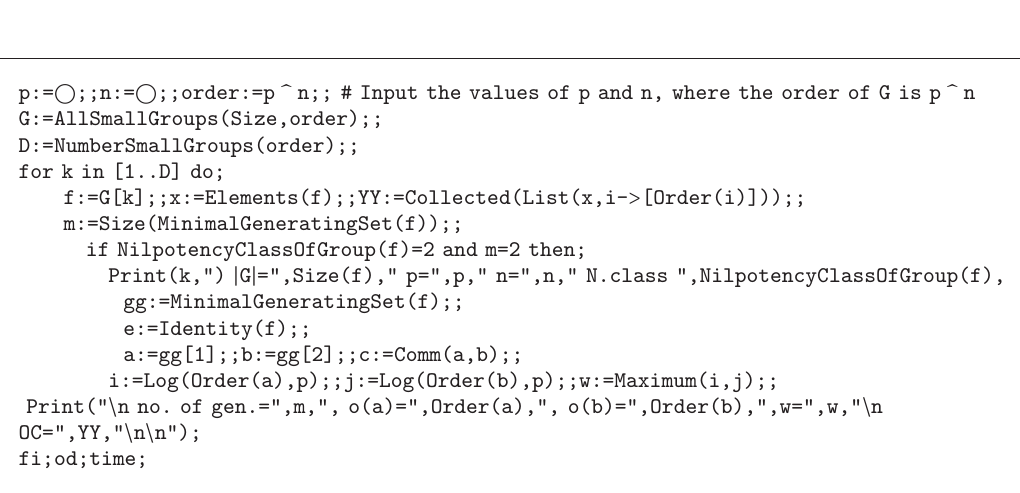
Algorithm 2: The ordinary GAP